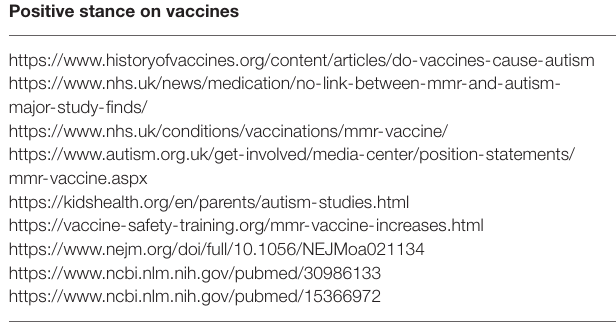
TABLE 1 | Example of classification of